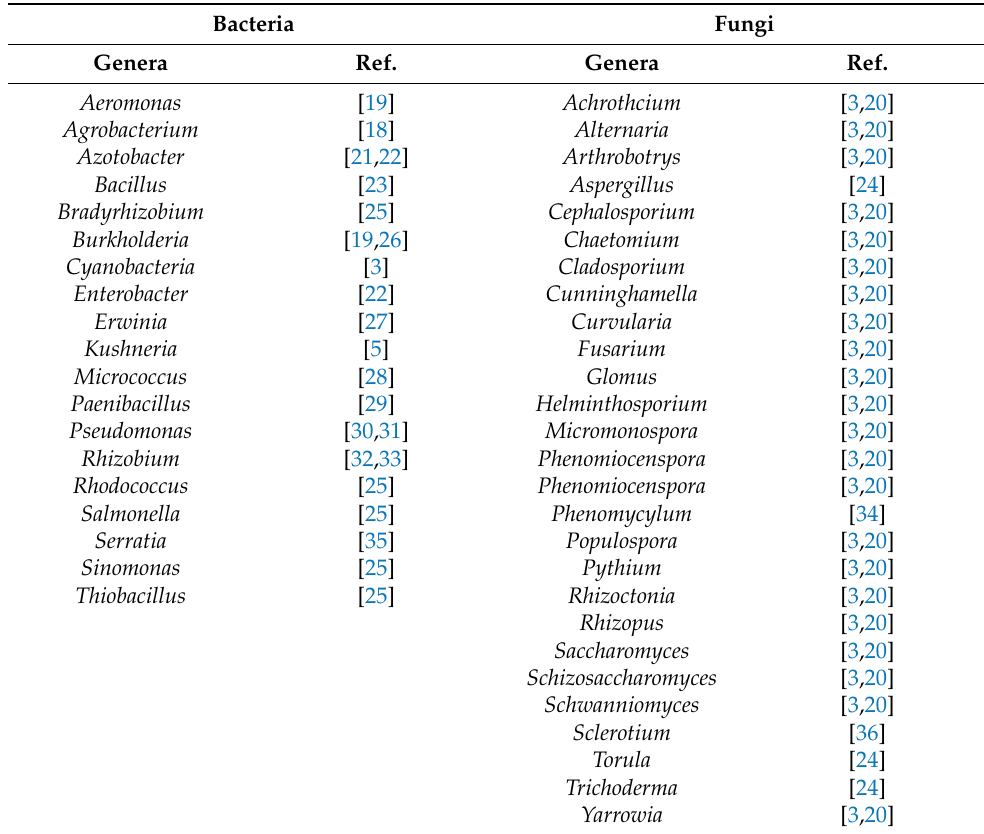
Table 1. Genera of soil phosphate-solubilizing bacteria and fungi. Bacteria